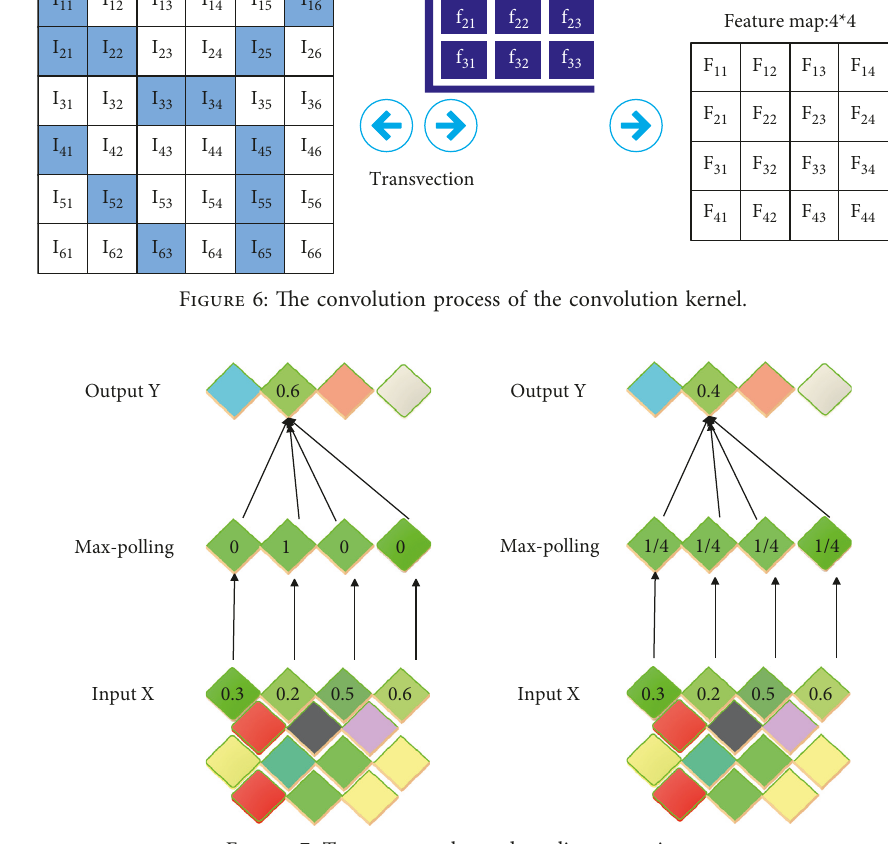
Figure 7: Two commonly used pooling operations.